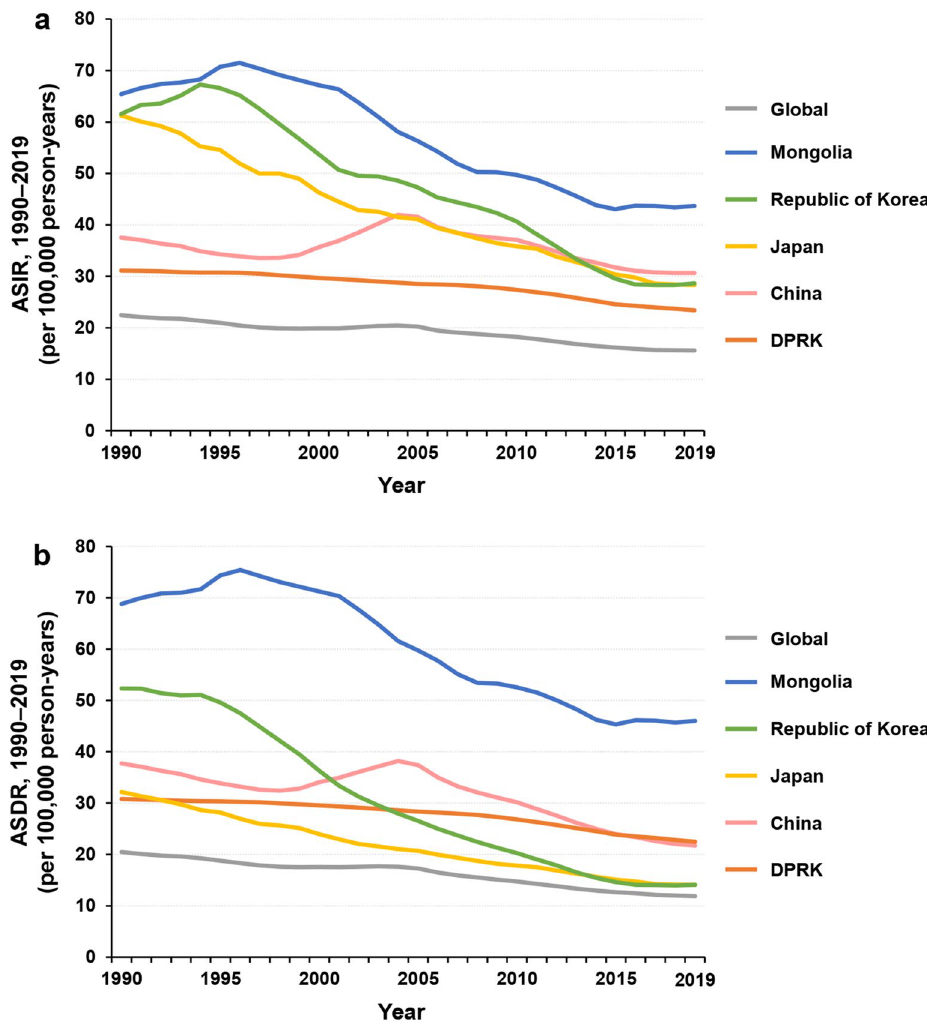
Figure 3. Time trends of ASIRs ( a ) and ASDRs ( b ) of gastric cancer worldwide and in five Asian countries from 1990 to 2019. ASDR, age-standardized death rate. ASIR, age-standardized incidence